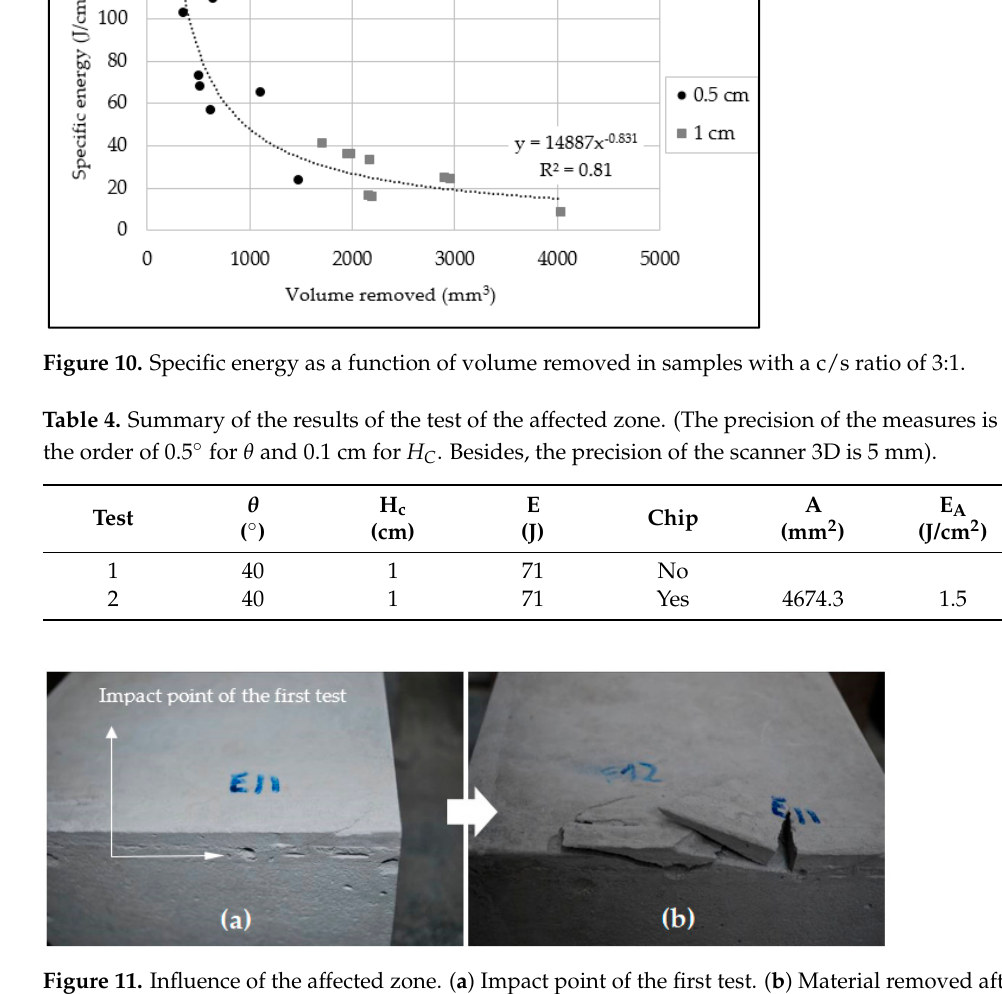
Table 5. Summary of optimum energy calculation tests. (The precision of the measures is of 0.5 ° for θ , and 5 mm for the scanner).